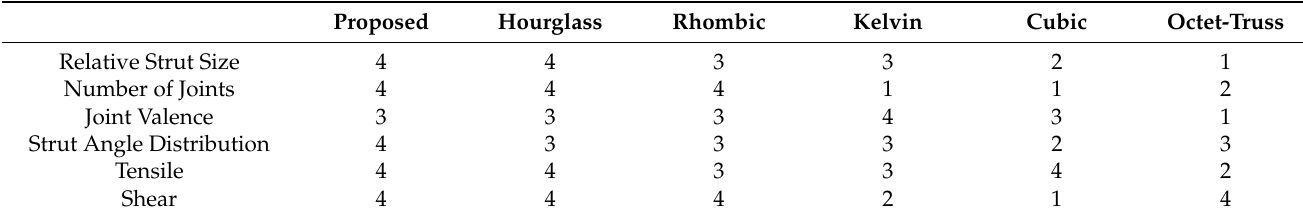
Table 8. Lattice topology performance grading. 4: very good, 3: good, 2: fair, 1: